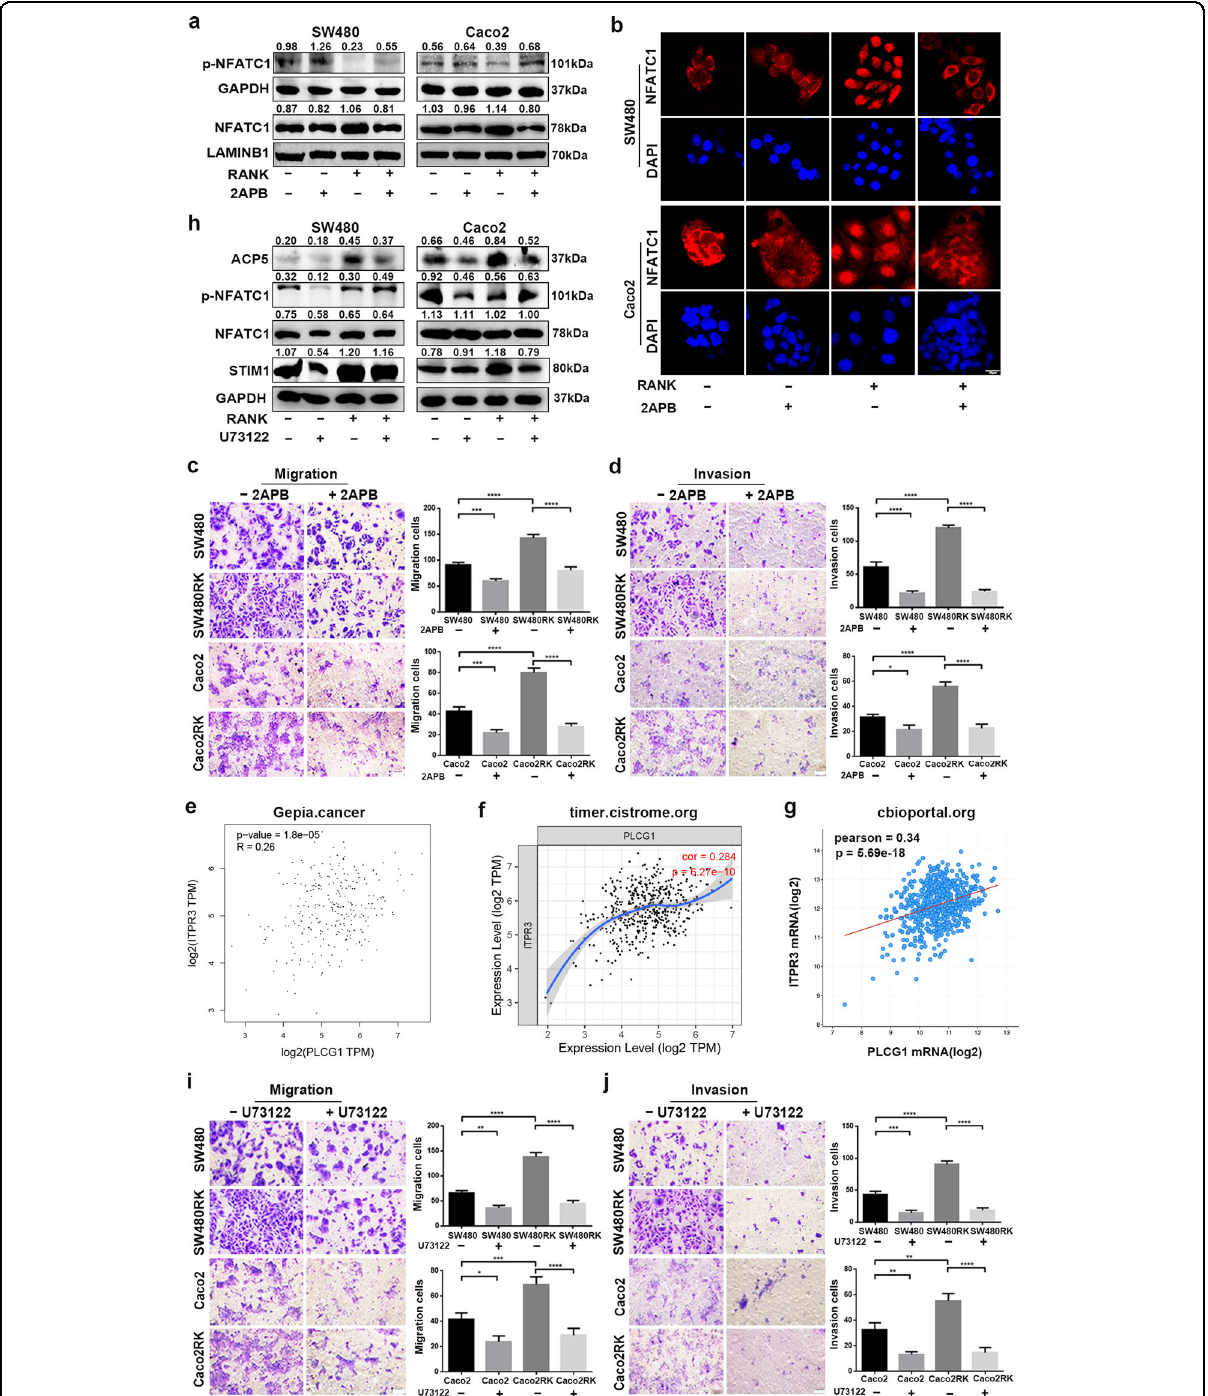
Fig. 7 RANK induced STIM1-mediated Ca 2 + in fl ux and ER Ca 2 + release by activating the PLC γ -IP3R axis. a Western blotting analyzed the protein levels of NFATC1 and phosphorylated NFATC1 in nuclear and cytoplasm of 100 μ M 2APB-treating CRC cells. b Immuno fl uorescence staining showed nucleocytoplasmic localization of NFATC1 in CRC cells treated by 100 μ M 2APB. Blue represents DAPI staining. Scales bars = 20 μ m. c , d A total of 100 μ M 2APB rescued RANK-mediated migration and invasion of SW480 and Caco2 cells. Scales bars = 100 μ m. e – g Scatter plots showed the signi fi cant positive relationship between mRNA expressions of IP3R and PLC γ obtained by online datasets. PLCG1 , PLC γ . ITPR3 , IP3R . h A total of 10 μ M U73122 rescued the protein levels of STIM1, ACP5, and the phosphorylation level of NFATC1 in SW480RK and Caco2RK cells. i , j Representative images of CRC cells treated by 10 μ M U73122 subjected to the transwell migration and invasion assays. Scales bars = 100 μ m. Data are mean ± SD ( n = 3). * P < 0.05, ** P < 0.01, *** P < 0.001, **** P <